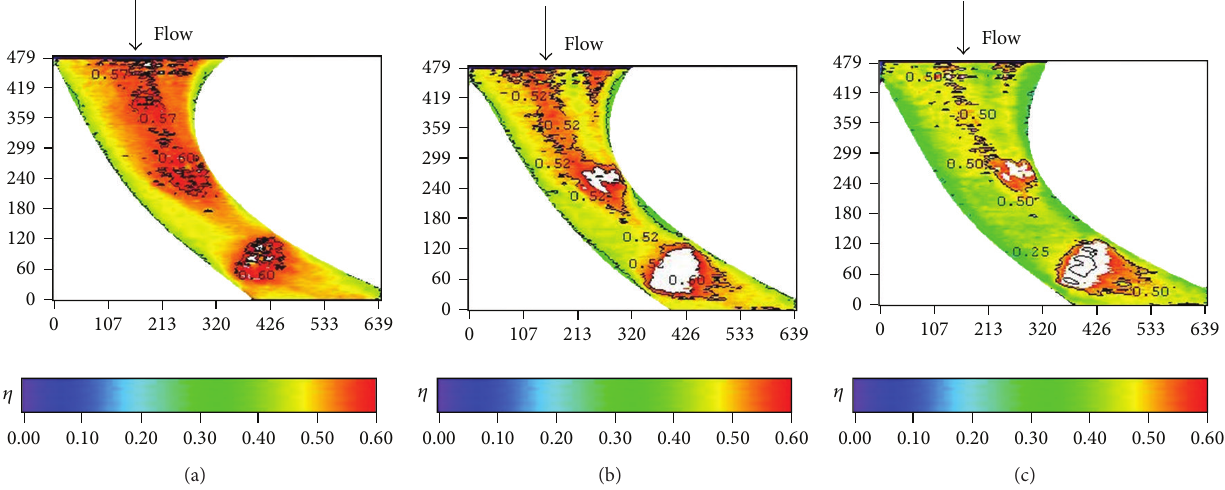
Figure 7: Effect of Reynolds number on averaged effectiveness at high turbulence intensity ( 𝑆/𝐶 = 0 %, 𝑀 = 1 , and T . I . = 12 %).